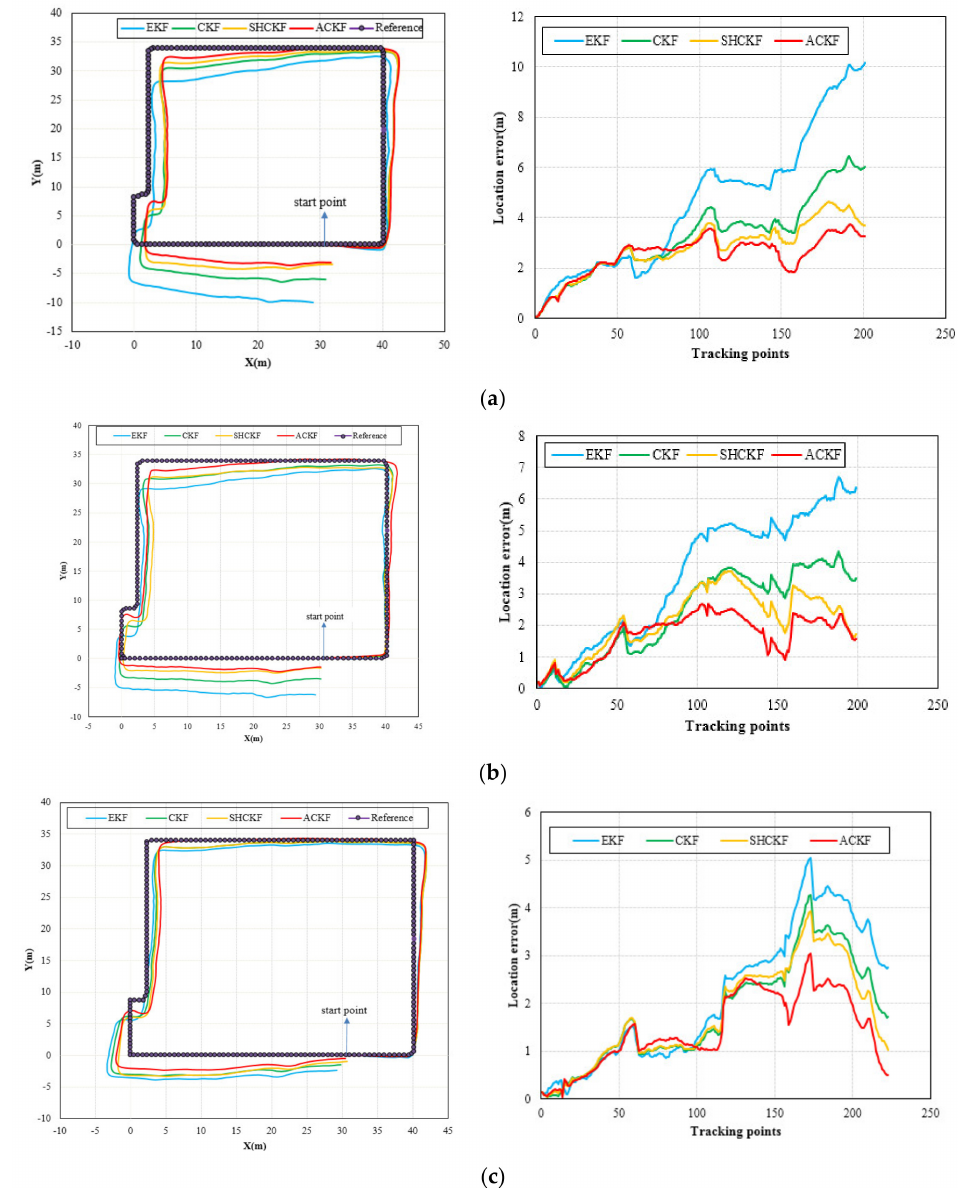
Figure 10. Distributions of location errors in location tracking of EKF, CKF, SHCKF, and ACKF for three participants, ( a ) participant 1, ( b ) participant 2, and ( c ) participant 3.